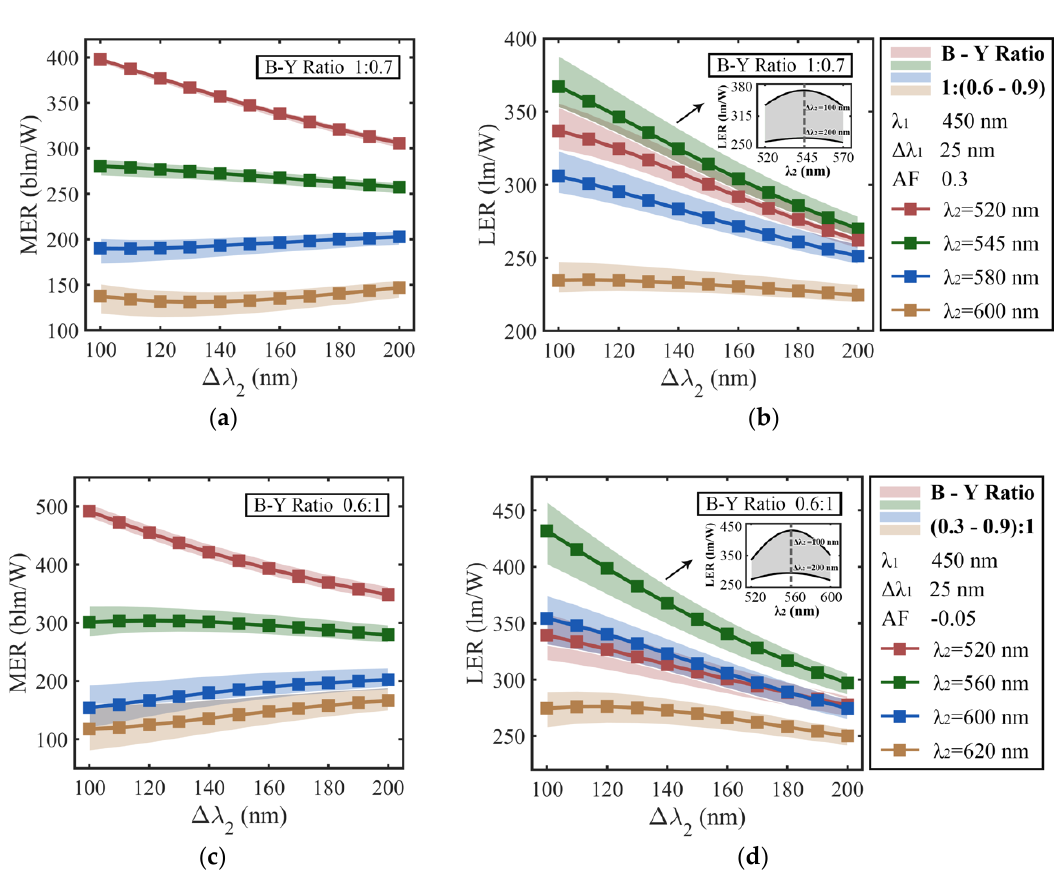
Figure 3. Melanopic effeciency of radiation (MER) and luminous efficiency of radiation (LER) as functions of λ 2 and Δλ 2 at different B:Y ratios: ( a ) MER and ( b ) LER with the peak wavelengths of phosphor (λ 2 ) ranging from 520 to 600 nm and the full widths at half maximum (FWHMs) of phosphor (Δλ 2 ) ranging from 100 to 200 nm at a blue:yellow intensity ratio (B:Y ratio) of 1 to 0.7, ( c ) MER and ( d ) LER with λ 2 ranging from 520 to 620 nm and Δλ 2 ranging from 100 to 200 nm at a B:Y ratio of 0.6 to 1. For all the spectra, the peak wavelength and FWHM of the blue LED are fixed at: λ 1 = 450 nm, Δλ 1 = 22 nm. The asymmetric factor (AF) of phosphor is 0.3 and -0.05, respectively.